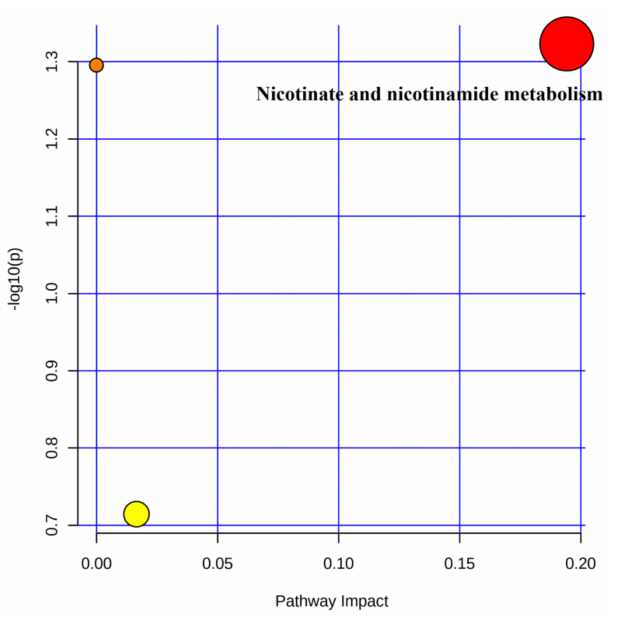
Figure 7. Metabolic pathways of post-training urine and post-competition differential